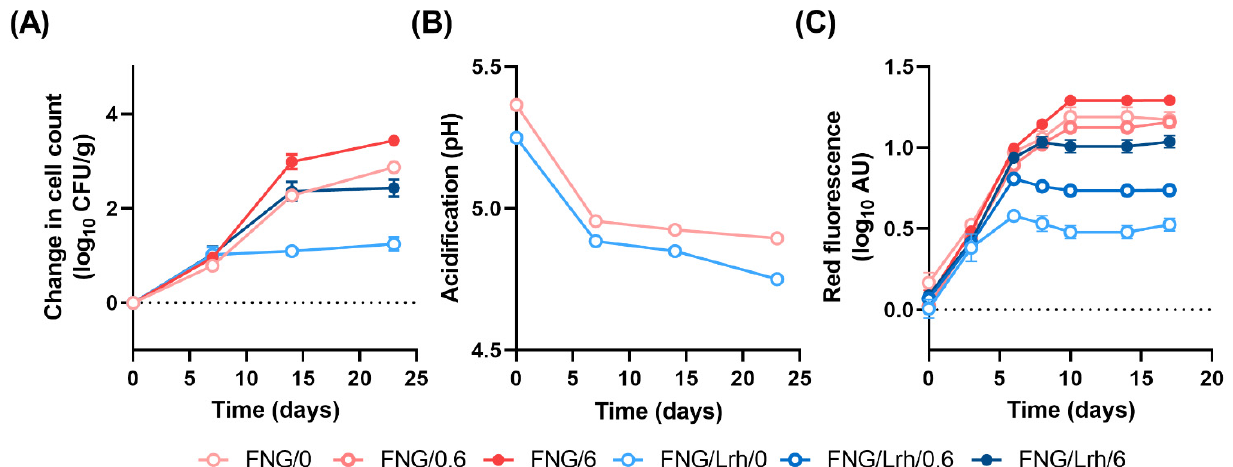
Figure 5. Effect of Mn supplementation on growth of Listeria spp. in cottage cheese prepared with or without Lrh-FQ. Depicted in ( A ) are changes in L. monocytogenes CFU/g in FNG or FNG/Lrh-FQ (FNG/Lbh) industrial cottage cheeses to which no or 6 mg/L MnCl 2 was added after mixing. The corresponding acidification profiles of the non-contaminated control cheeses are shown in ( B ). Averaged measurements were obtained from three cheeses per condition. ( C ) The development of red fluorescence by RFP-tagged L. innocua after inoculating industrial cottage cheeses supplemented with no, 0.6 mg/L or 6 mg/L MnCl 2 , and incubated at 10 °C for 17 days.